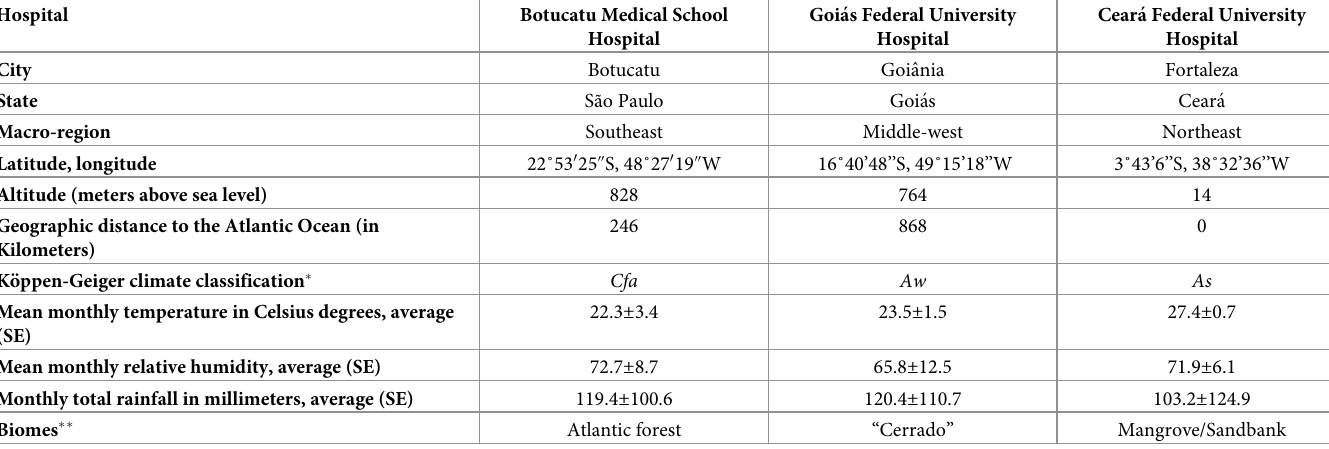
Table 1. Climatic and geographic characteristics of the municipalities where the study hospitals are